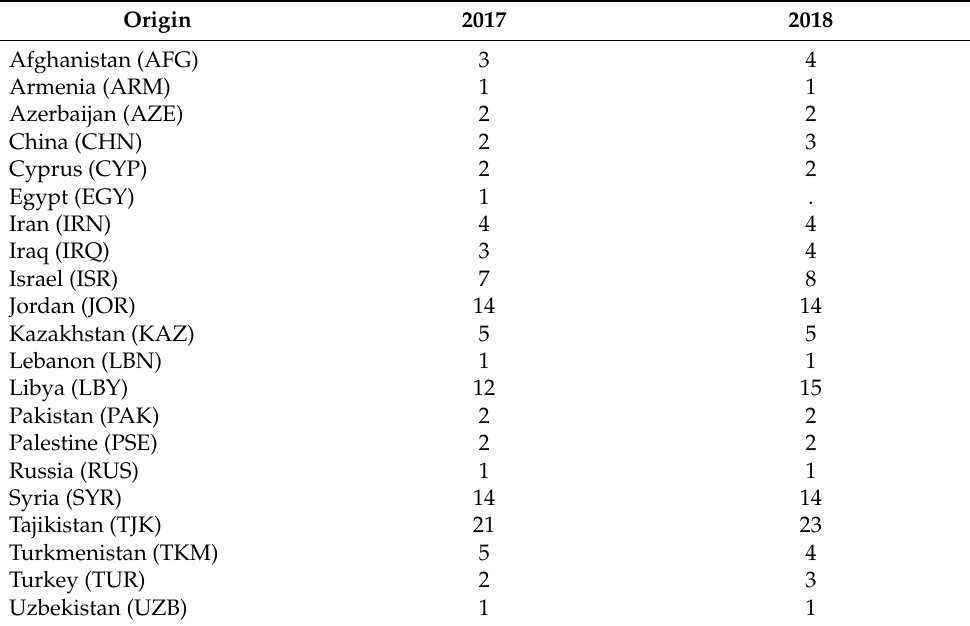
Table 1. Number of accessions and country of origin of accessions of Hordeum spontaneum evaluated in 2017 and 2018